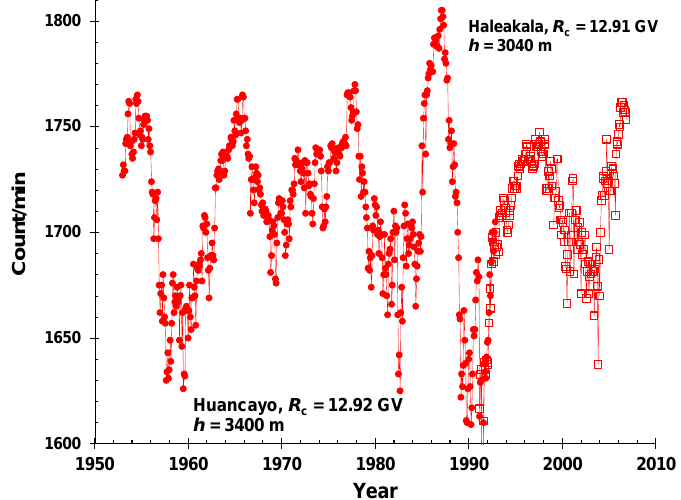
Figure 8. Time dependence of monthly average count rates of neutron monitors Huancayo (points, R c = 12.9 GV , h = 3400 m a.s.l.) and Halleakala (open squares, R c = 12.9 GV, h = 3030 m a.s.l.). The data were smoothed over 12 points. Data normalization was performed for the period 1992 – 1998.